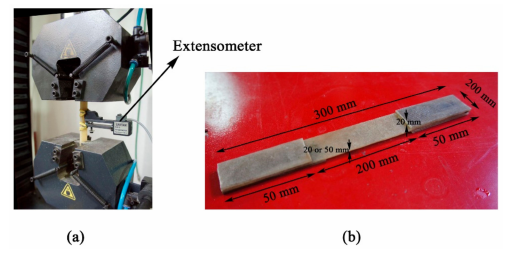
Figure 3. Tensile test: ( a ) Test set-up and ( b ) sample